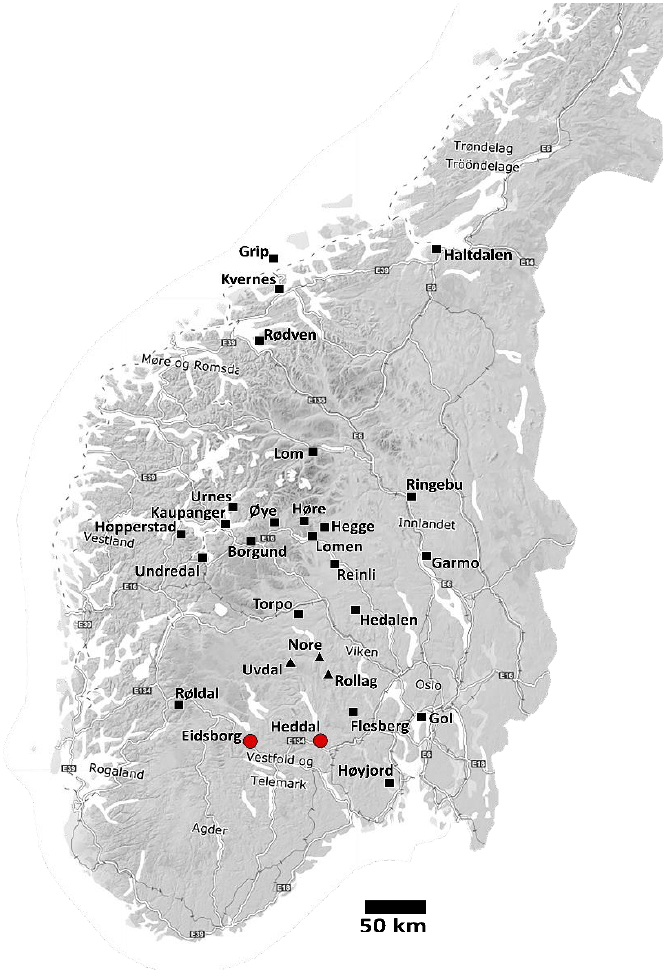
Figure 1. Map of the 28 remaining Norwegian stave churches, where the red circles denote churches examined in the present case study. Map is adapted from the website of Kartverket (the Norwegian Mapping Authority).